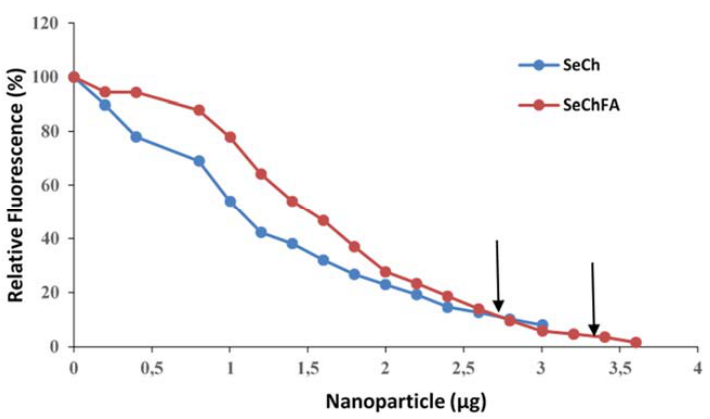
Figure 4. Ethidium bromide intercalation assay showing siRNA compaction of SeCH and SeChFA: Arrows indicate end ‐ points.